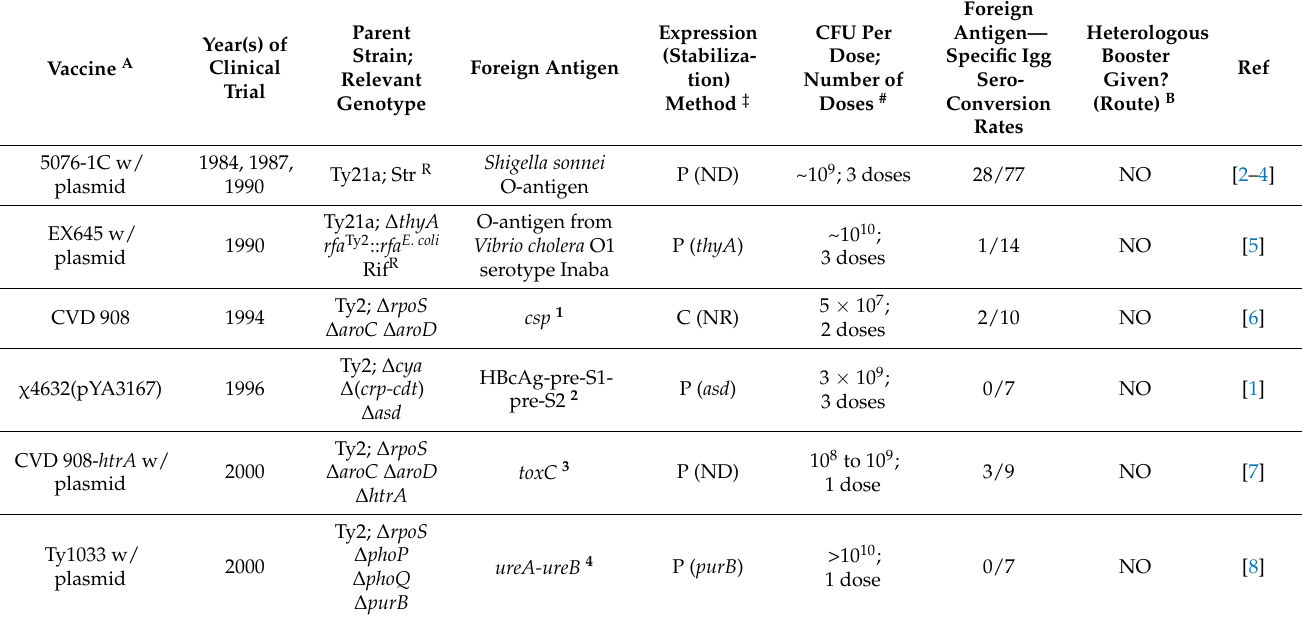
Table 1. Clinical trials of oral immunization with attenuated Salmonella enterica serovar Typhi attenuated carrier vaccines expressing foreign (heterologous)